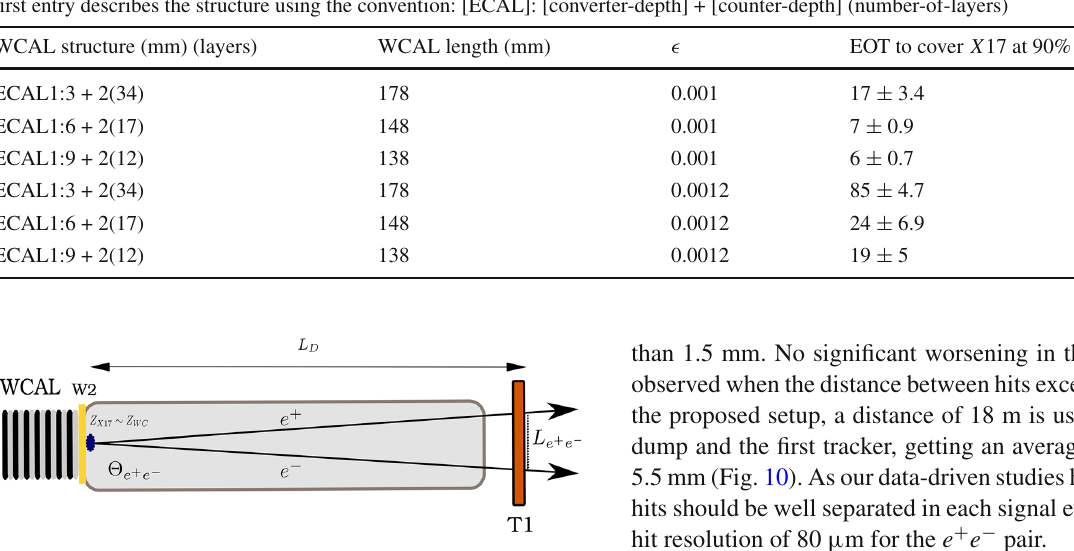
Fig. 9 Sketch of the X 17 decay in the proposed setup along the beam axis vertex and the first tracking detector (see Fig. 9).